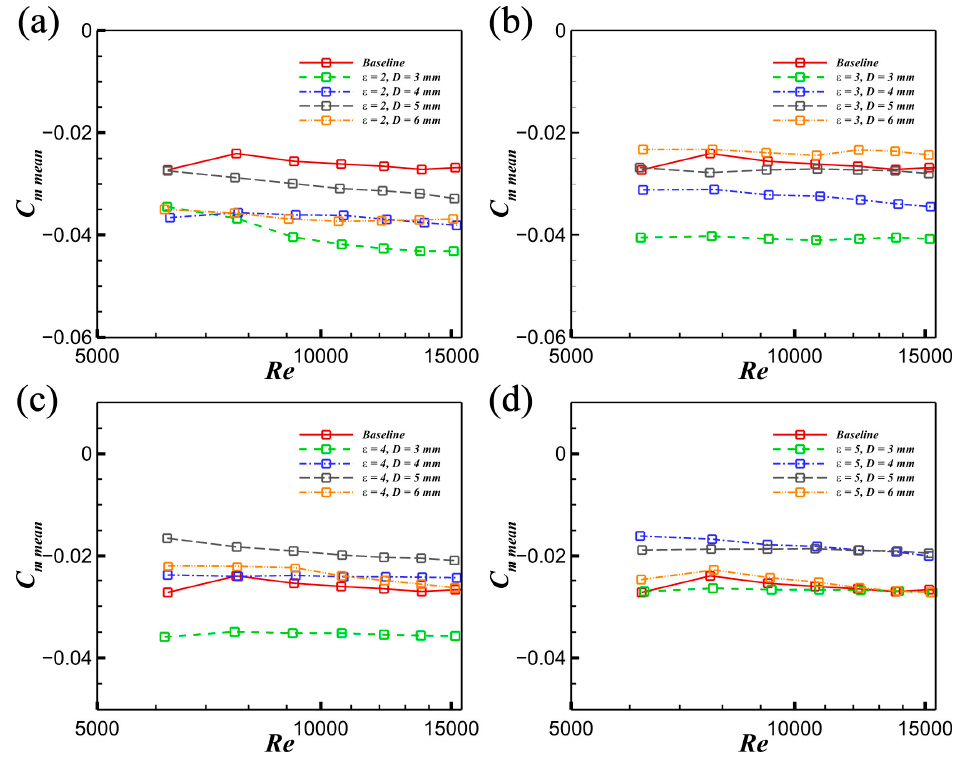
Figure 19. ( a – d ) The relationship between the time-averaged moment force coefficient and the Reynolds number at different spacing ratios and cylinder diameters.